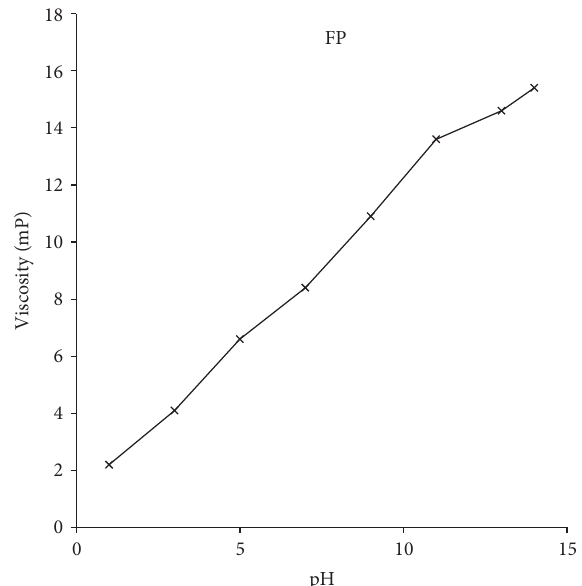
F 3: Variation of viscosity with pH for Ficus platyphlla (FP)